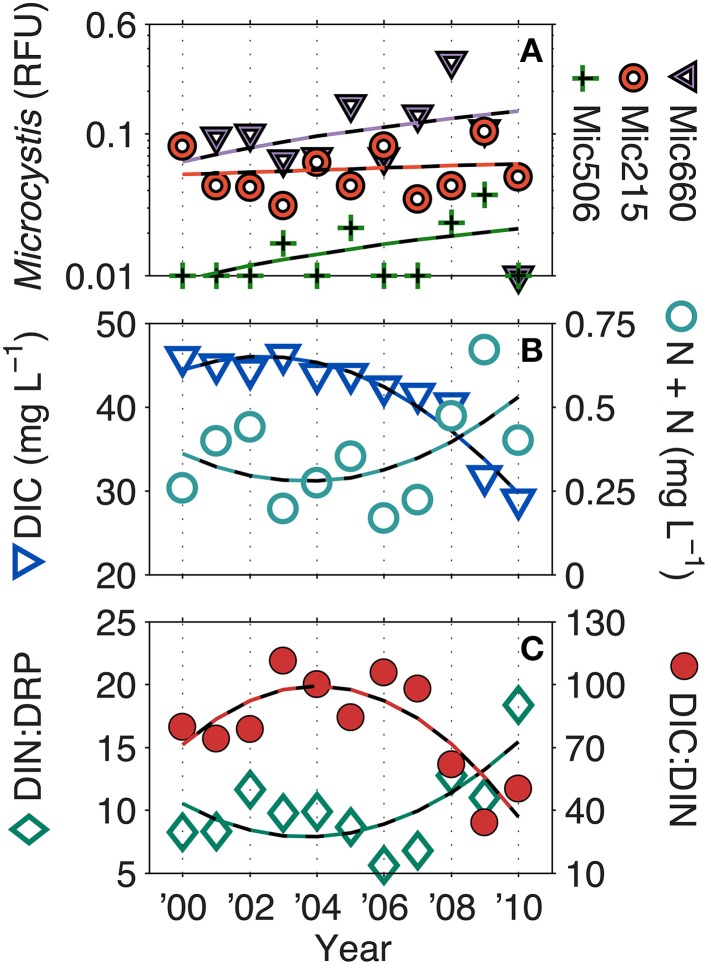
Long-term trends in (A) Microcystis genotypes, (B) dissolved inorganic carbon (DIC), nitrate + nitrite (N + N), and the (C) DIC: DIN and DIC: dissolved reactive phosphorus ratios (DRP) (ratios by mass). Dashed lines represent significant (p < 0.05) linear correlations for Microcystis genotypes and significant second order polynomial regressions for DIC, DIC: DIN, and DIN: DRP. N + N was not significant. Additionally, in 2008, South Central Wisconsin experienced a 100-year flood, which may account for some of biogeochemical changes observed at that time.